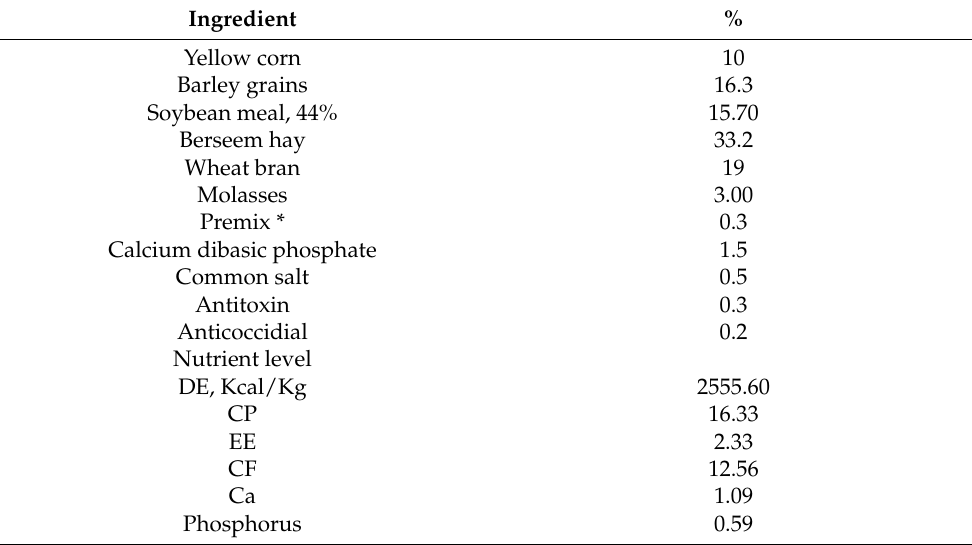
Table 1. Feed ingredients’ levels and nutrient composition of the control experiment diet. Ingredient % Yellow